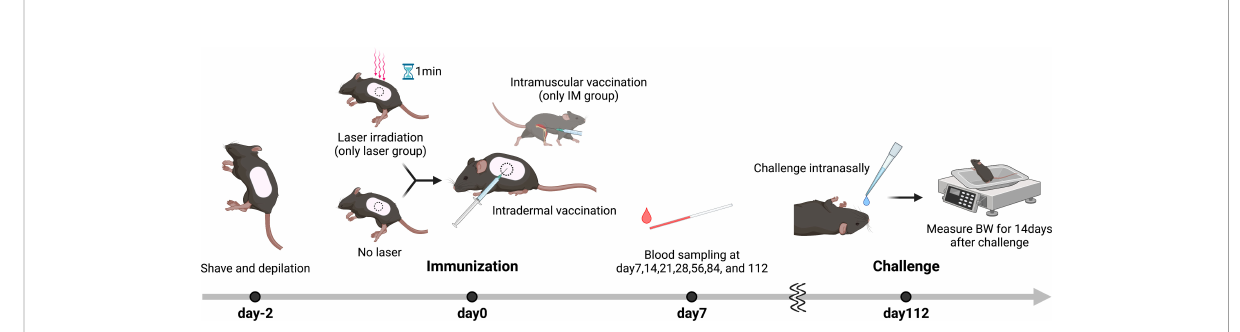
FIGURE 6 In fl uenza vaccination models with near-infrared (NIR) laser adjuvant. The back skin of wild type (C57BL/6J) mice were depilated with a commercial depilatory cream, 2 days before the NIR laser treatment and vaccination. Mice were vaccinated with 1 m g of whole inactivated in fl uenza virus (A/PR/8/34) with or without the NIR laser exposure (1064 nm CW 5 W/cm 2 for 1 min or 1270 nm CW 2 W/cm 2 for 1 min) or alum intradermally (ID) or intramuscularly (IM). Longitudinal blood serum was collected via the tail vein at day 7, 14, 21, 28, 56, 84, and 112. Mice were challenged intranasally with homologous live in fl uenza A/PR/8/34 virus at a dose of 5 × 10 5 50% egg infectious doses at day